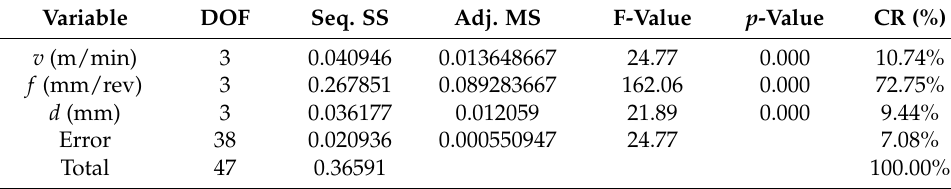
Table 5. Analysis of variance and percentage contribution results for SCE.